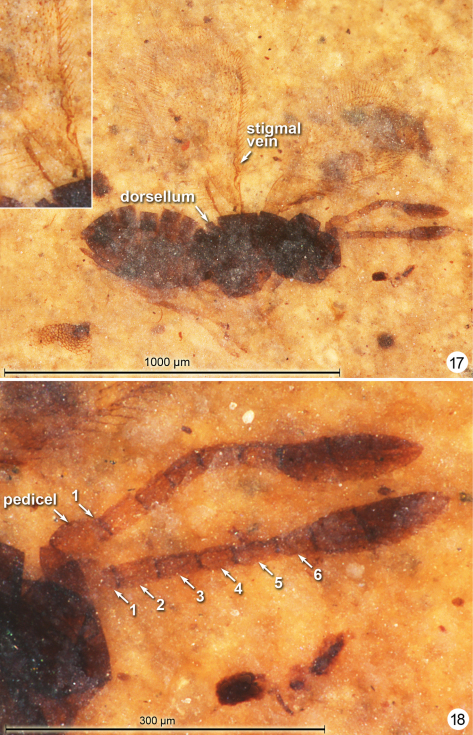
Eoanaphes stethynioides, holotype 17 habitus lateral (insert fore wing base) 18 antennae.